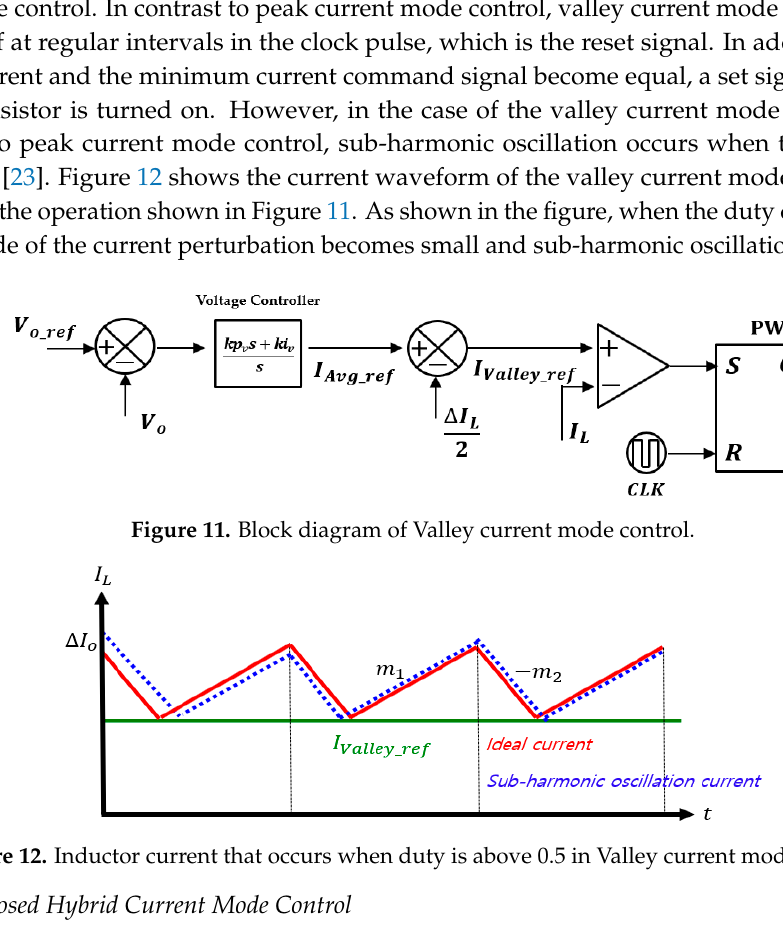
Figure 10. Duty cycle using different slopes.